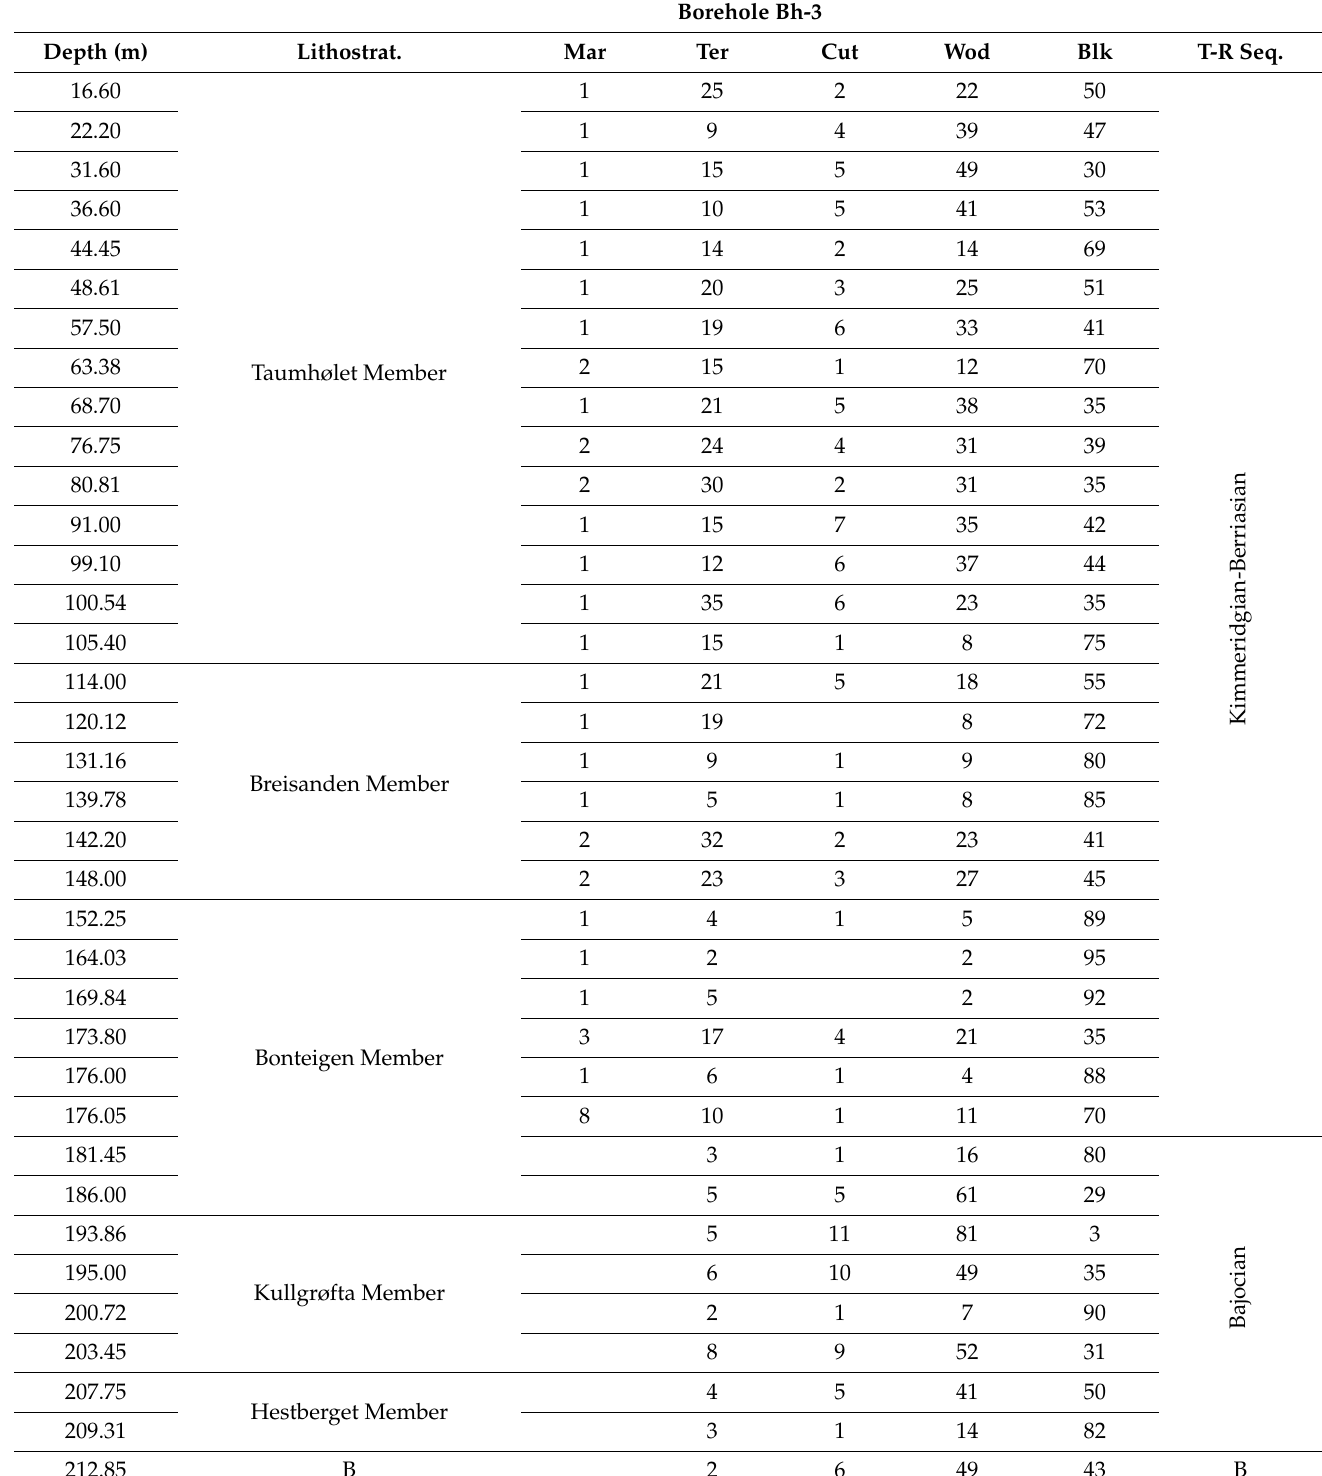
Table 3. Percentages of various groups of particulate organic matter (POM) in Borehole Bh 3. B = weathered basement. Mar = marine palynomorphs (acritarchs, dinoflagellate cysts, prasinophycean algae); Ter = terrestrial palynomorphs (pollen, spores); Cut = cuticule; Wod = Woody fragments; Blk = black, coaly fragments